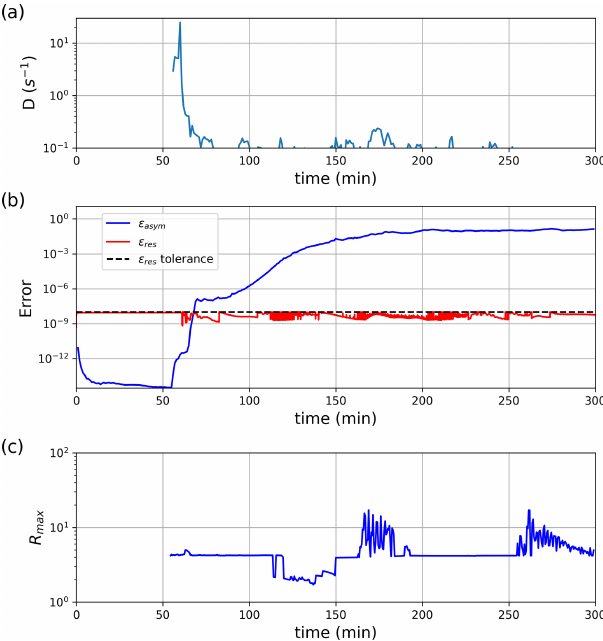
Figure 5. (a) Temporal evolution of the damage activity D ; (b) the solution residual (cid:15) res , asymmetry factor (cid:15) asym and convergence criterion on (cid:15) res ; and (c) the maximum error amplification ra- tio R max , in the control simulation using the standard stress cor- rection